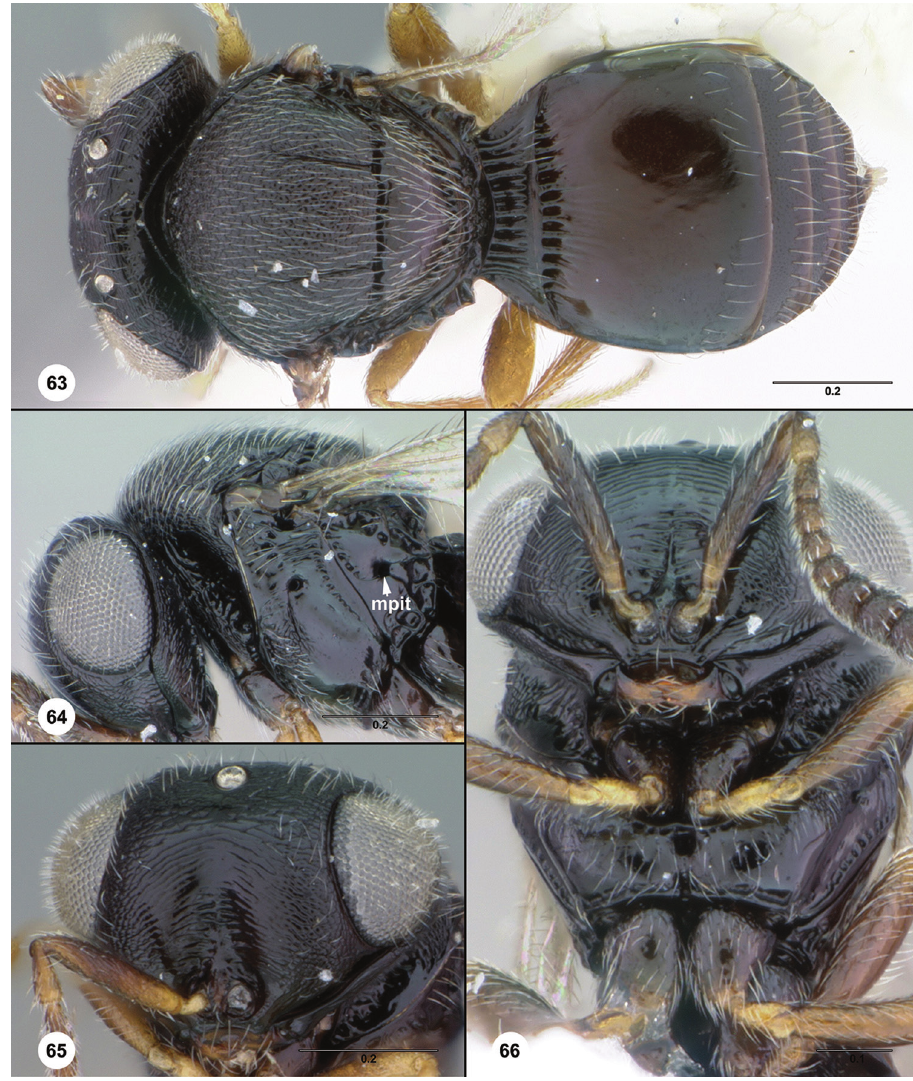
Figures 63–66. Trissolcus exerrandus 63 female holotype (ZMAS 0141), head, mesosoma, metasoma, dorsal view 64 female (USNMENT00896159), head and mesosoma, lateral view; 65 female holotype (ZMAS 0141), head, anterior view 66 female (USNMENT00896159), head and mesosoma, ventral view. Scale bars in